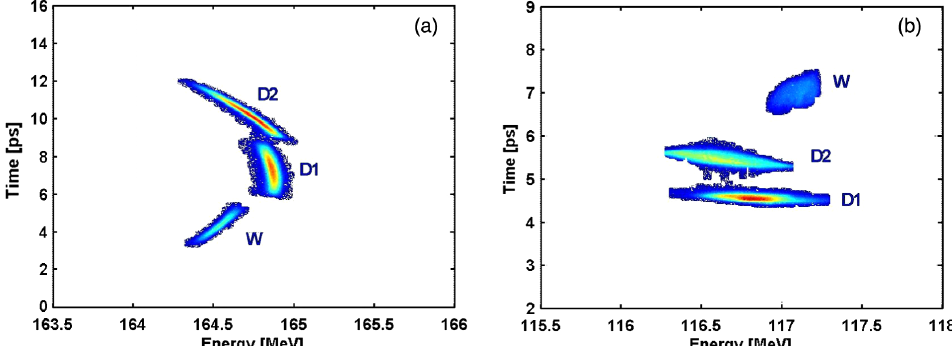
FIG. 2. (a) Measured longitudinal phase space with a comblike beam on crest. (b) Same structure at the overcompression phase which allows the bunches to be separated in time. The witness beam is indicated with W and the drivers with D1 and D2.